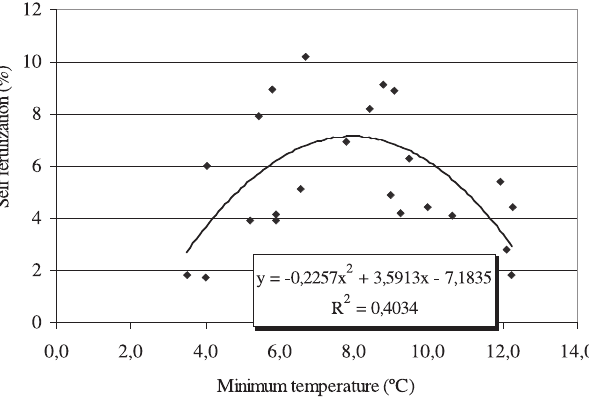
Figure 7: Relationship between self fertilization and average of minimum temperature during the blooming period at “Debreceni bôtermô” sour cherry cultivar (Újfehértó,